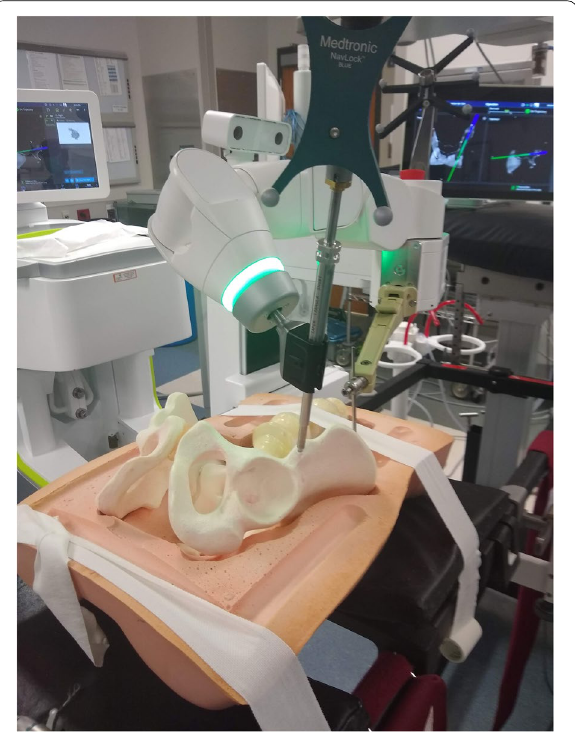
Fig. 4 Tap diameter 5.5 mm seated to the shoulder to prepare initial screw